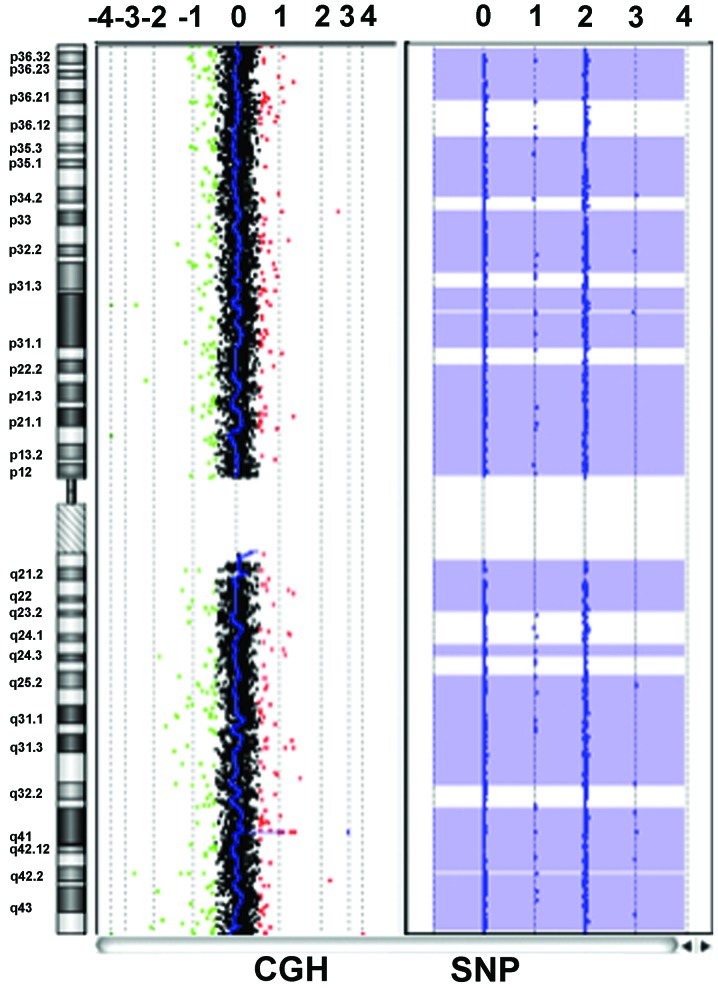
Results of chromosomal microarray testing using the comparative genomic hybridization and single nucleotide polymorphism (CGH + SNP) platform. The results of genomic copy number (left) and loss of heterozygosity (LOH) status (right) are shown for chromosome 1 of patient 2 according to the chromosome view of the Agilent Genomic Workbench. No genomic copy number aberration was detected in chromosome 1. Regions showing LOH status, judged by computer analysis, are depicted in purple; other non-LOH regions are considered to be false due to SNP artifacts. Patient 2 was, therefore, regarded to have LOH across the entire chromosome 1.